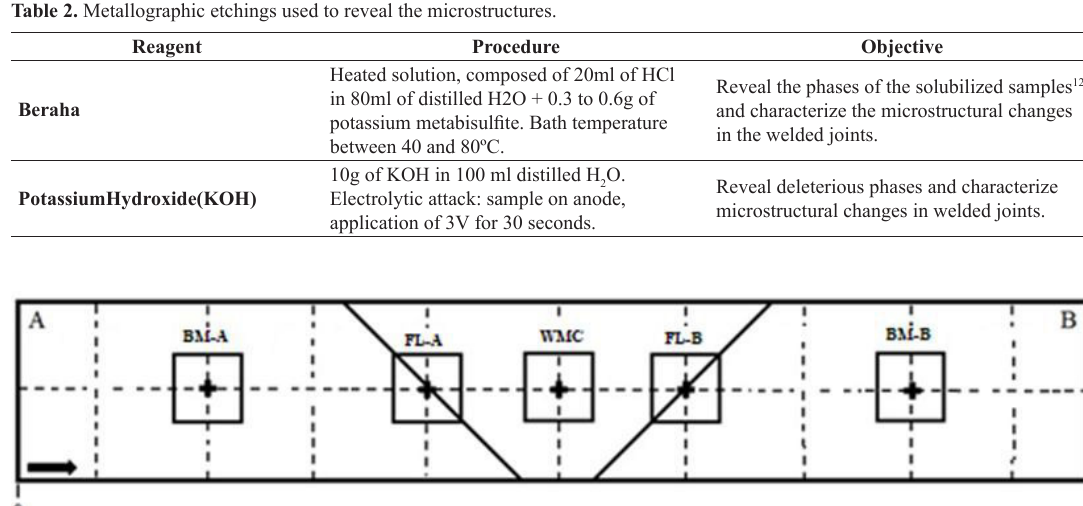
Figure 1. Schematic drawing of the cross section of weld joint showing the regions for the non-destructive microstructural